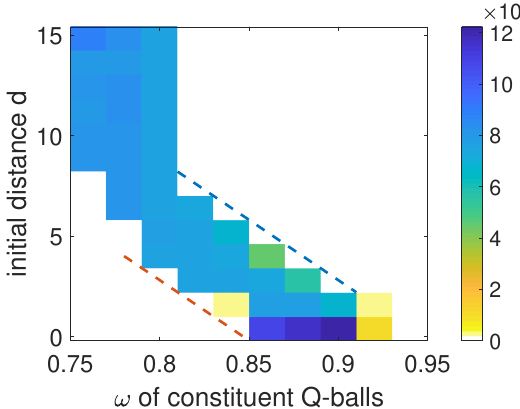
Figure 18. Lifespans of a dipole CSQ with different initial parameters. The parameter space is spanned by the internal frequency ω of constituent Q-balls and the initial distance d between the Q-ball centers. Lifetimes are shown in units of T = 2 π/m . The white regions are where CSQ can 0 not form. The two dashed guiding lines are d + 60 ω = 50 . 8 and d + 60 ω = 56 . 8 respectively.